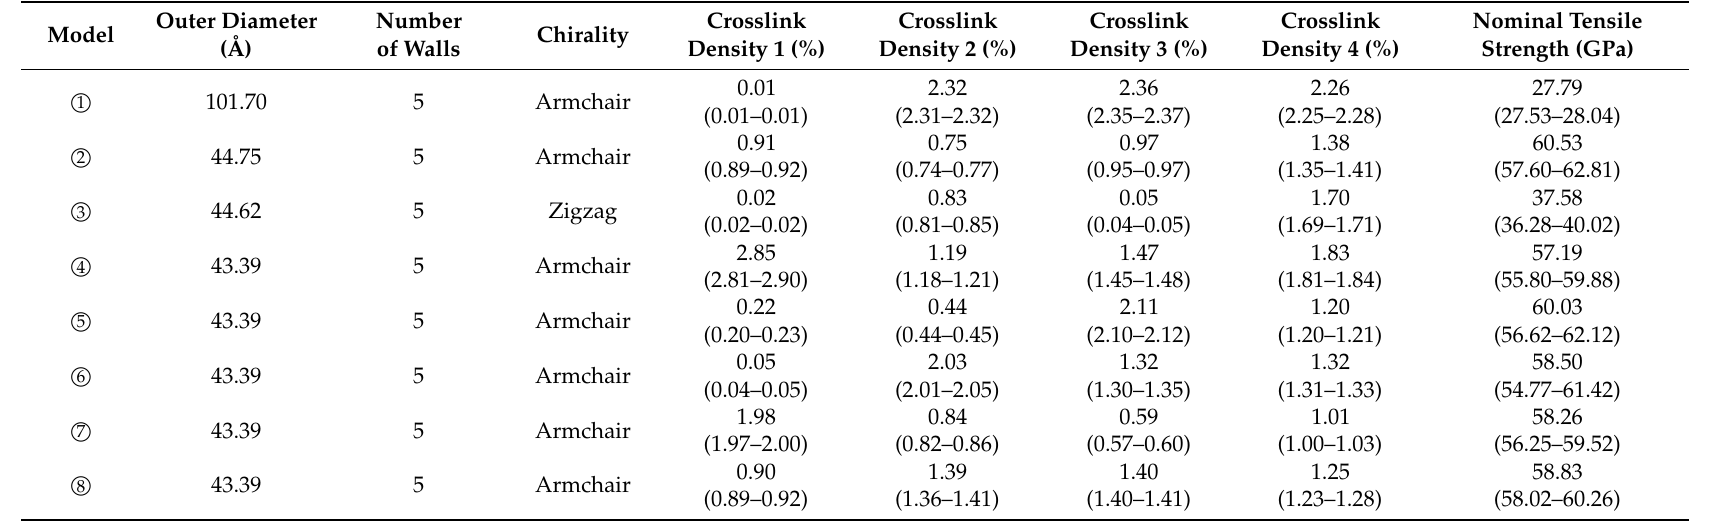
Table 1. Detailed information for the representative values in Figure 4. “Crosslink density 1” through “Crosslink density 4” represent the crosslink densities between each adjacent wall from the inner tube to the outer tube. The average value is given, and the range is indicated in